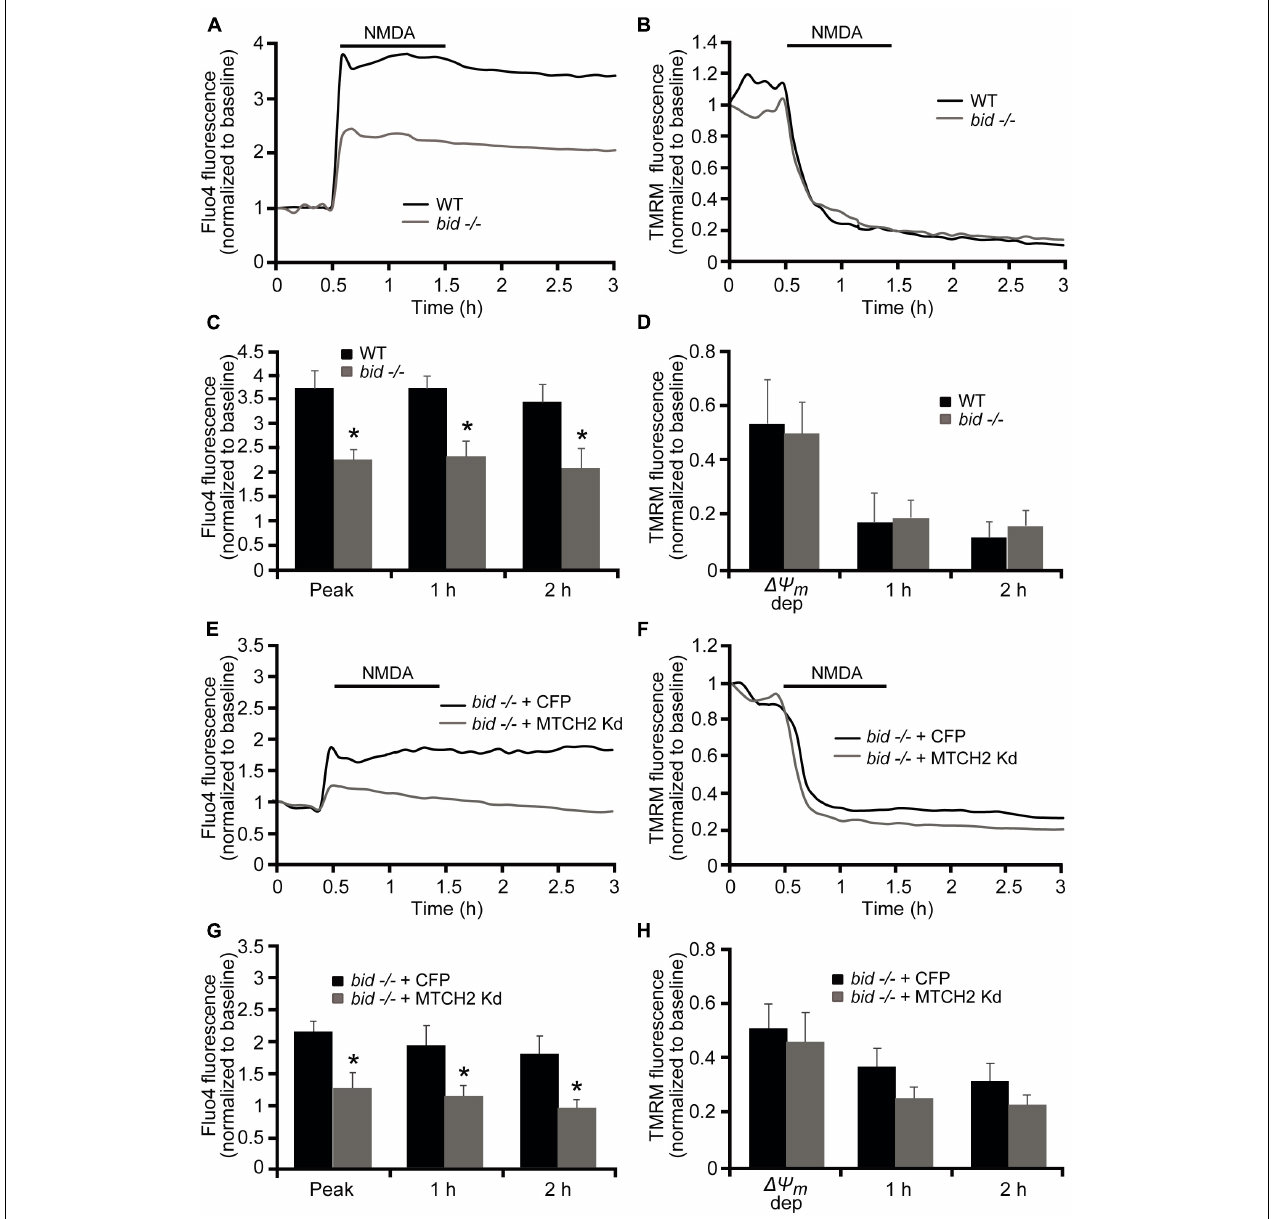
FIGURE 4 | Mtch2 gene silencing attenuates NMDA-induced Ca 2 + overloading in bid -deficient cortical neurons. (A–D) WT and bid- deficient cortical neurons, cultured separately on Willco dishes, were preloaded with TMRM (20 nM) and Fluo-4 AM (3 µ M) for 30 min at 37 ◦ C before being monitored by a confocal microscope (LSM 510Meta). Neurons exposed to 300 µ M NMDA for 60 min were monitored in single-cell imaging for alterations in TMRM fluorescence and intracellular Ca 2 + over a 3 h period. Representative traces of NMDA-treated WT and bid -deficient cortical neurons depicting the extent of peak Ca 2 + influx at point of stimulation and ICD (A) , and TMRM fluorescence loss (B) after the excitotoxic stilmulus (300 µ M/60 min NMDA) are shown. Analysis of the Fluo-4 fluorescence (C) and average of TMRM fluorescence (D) at the indicated time points during and after NMDA exposure (300 µ M/60 min) was performed in WT ( n = 83) and bid -deficient ( n = 43) neurons. Data are means ± SEM from at least n = 3 independent experiments for each genotype. * p ≤ 0.05 compared to NMDA-treated WT controls (ANOVA, post hoc Tukey). (E–H) bid -deficient neurons, transfected with an shRNA plasmid against Mtch2 or a control empty vector (ECFP) for 36 h and co-loaded with TMRM (20 nM) and Fluo-4 AM (3 µ M), were exposed to NMDA (300 µ M/60 min NMDA) and monitored by confocal microscopy (LSM 710). Representative Fluo4-AM (E) and TMRM (F) traces measuring alterations in intracellular Ca 2 + influx and TMRM fluorescence, respectively, at point of stimulation (300 µ M/60 min NMDA) and following the initial excitotoxic stimulus. Analysis of the relationship Fluo-4 fluorescence at the indicated time points compared to peak Fluo-4 AM fluorescence at NMDA exposure (G) . bid -deficient cortical neurons transfected with Mtch-2 kd plasmid: n = 20 neurons from n = 5 separate cultures. Empty vector: n = 28 neurons from n = 5 separate cultures. Data are shown as means ± SEM. * p ≤ 0.05 compared to NMDA-treated bid -deficient controls (ANOVA, post hoc Tukey). Average of TMRM fluorescence in bid -deficient cortical neurons transfected with Mtch-2 kd plasmid ( n = 20; from n = 5 separate cultures) or control vector ( n = 28; from n = 5 separate cultures) during and after NMDA excitation (H) . Means ± SEM are shown ( p ≥ 0.05; ANOVA, post hoc Tukey’s test).